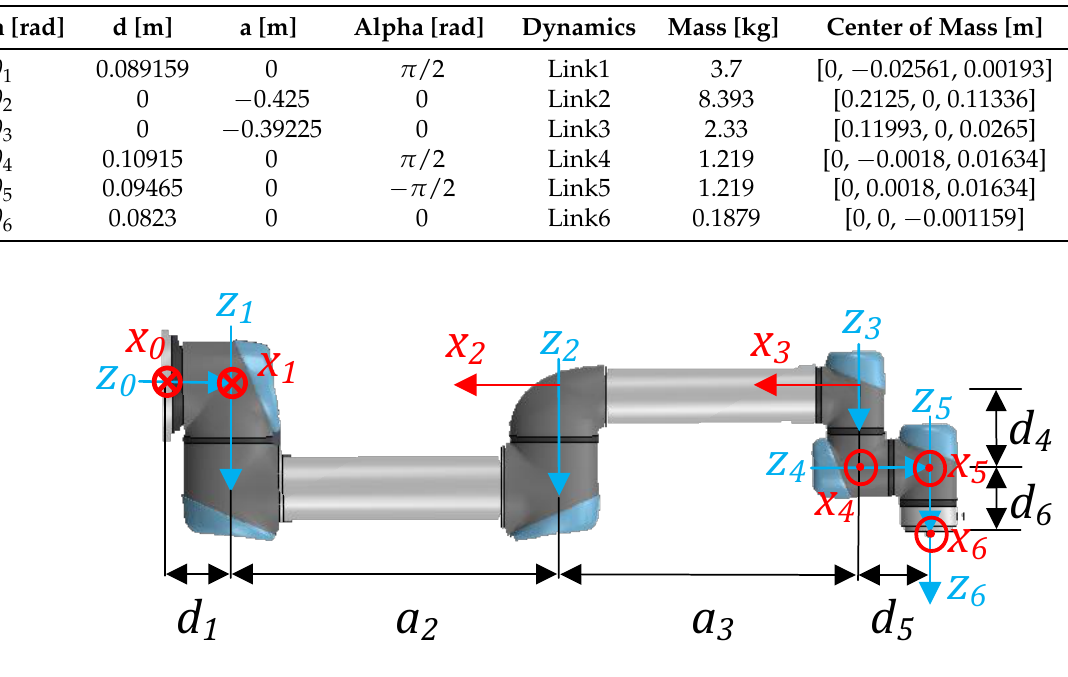
Table 2. D-H parameters and dynamic parameters of the UR5 robot.